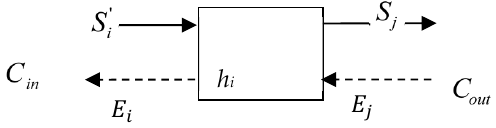
Figure 3. Incoming Send stream is chaffed.